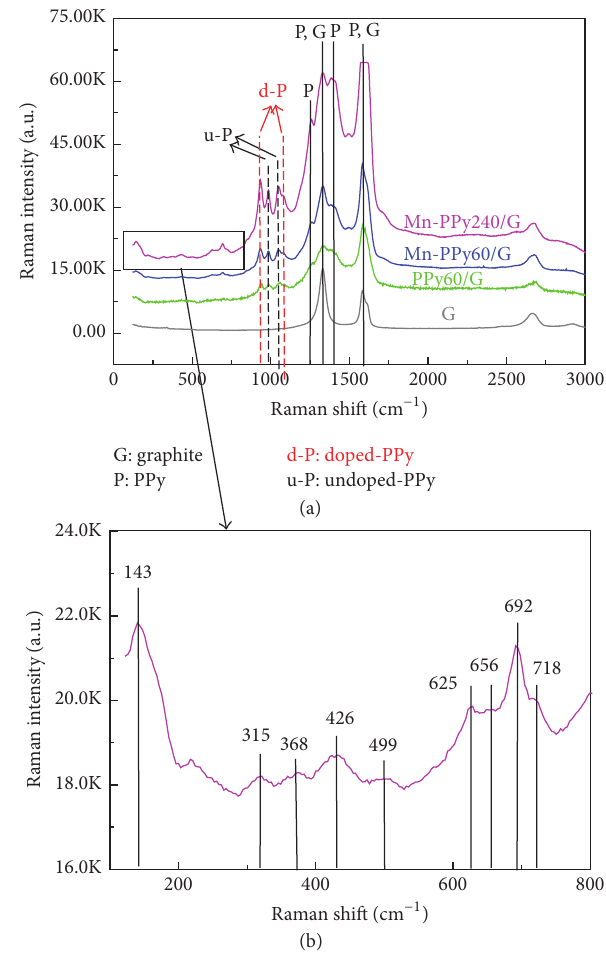
Figure 7: (a) Micro-Raman spectra of the graphite support (G) andofPPy60/G,Mn-PPy60/G,andMn-PPy240/Gelectrodeposited catalysts. (b) Magnification in the range 100–800 cm −1 to highlight the MnO 𝑥